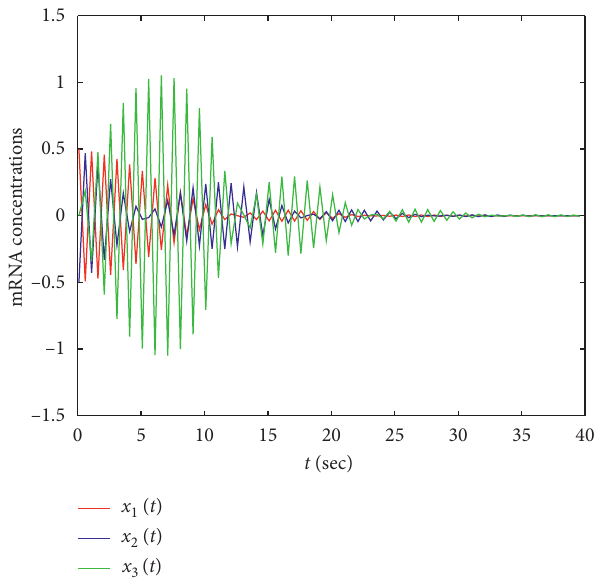
Figure 1: The mRNA concentrations x ( t ) in Example 1.